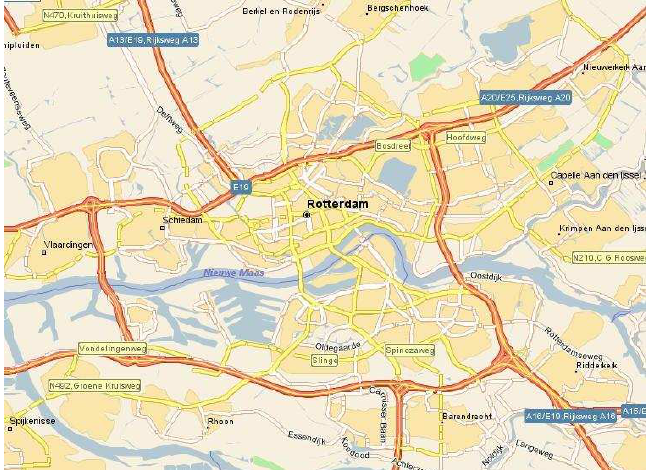
Figure 4. The case study area, the ring road around Rotterdam, left to right around 25